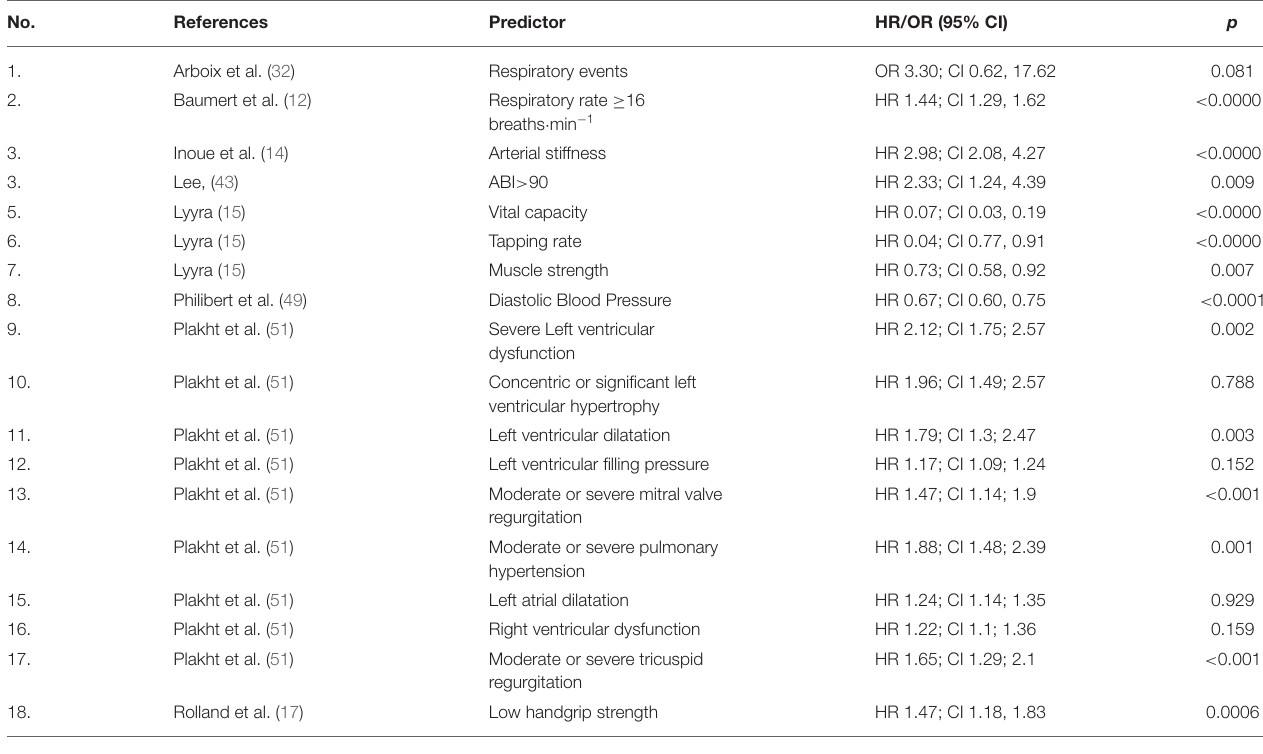
TABLE 3 | Additional predictors of Mortality.